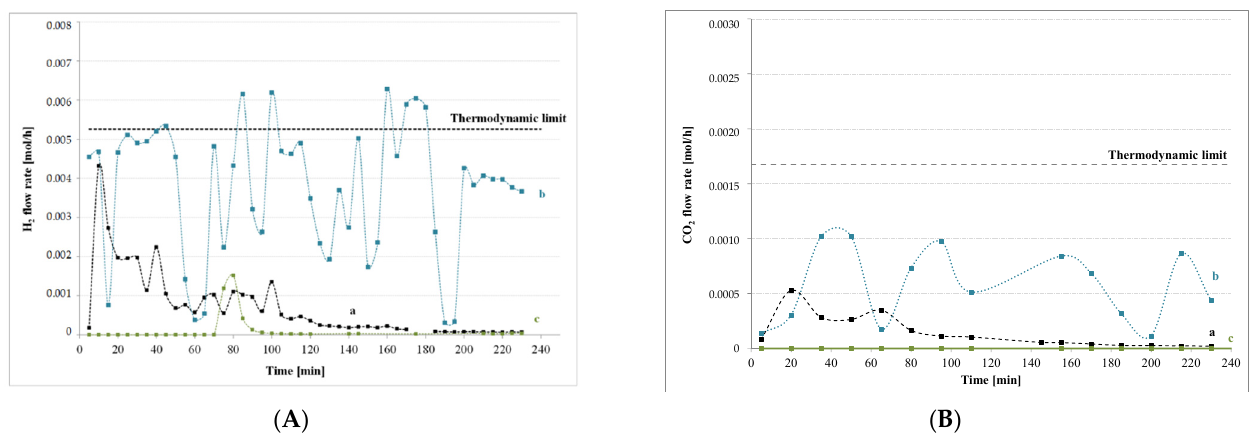
Figure 8. Reactivity in steam toluene reforming tests at 640 ◦ C for (a) C100Ni3, (b) C56Ni3, and (c) MayNi3. H 2 flow rate ( A ) and CO 2 molar flow ( B ).